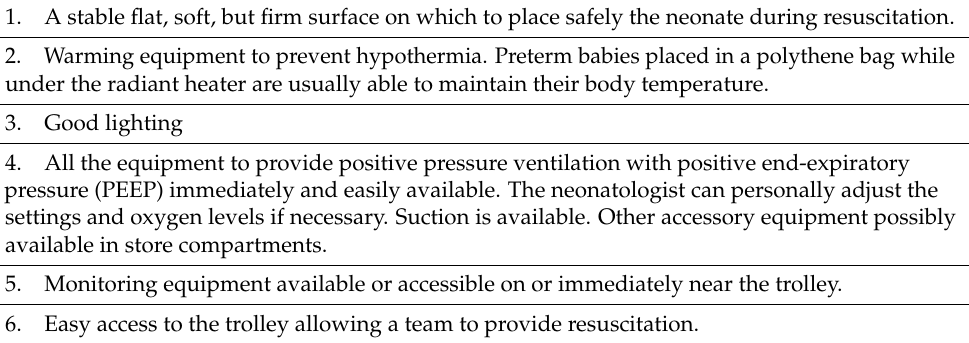
Table 1. Basic features to be assured in motherside neonatal resuscitation.